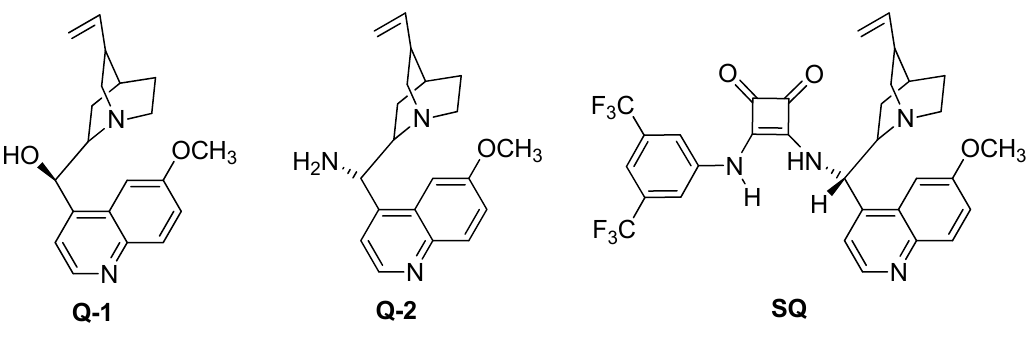
Scheme 2. Synthesis of the chiral β -amino acid